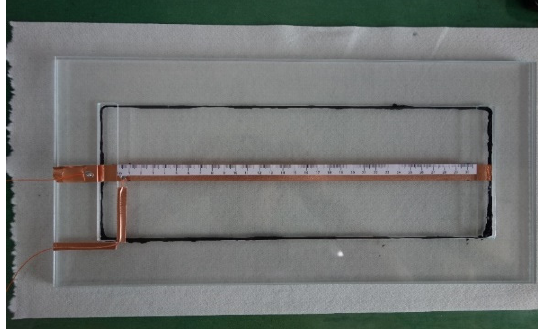
Figure 1. Process diagram.